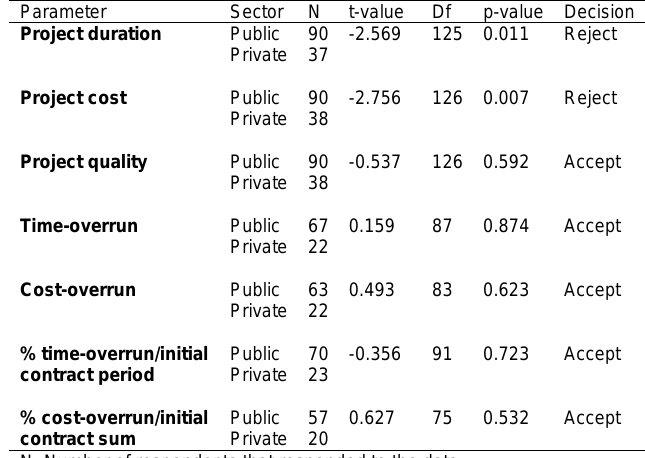
Table 5: Results of t-test for differences in the performance of